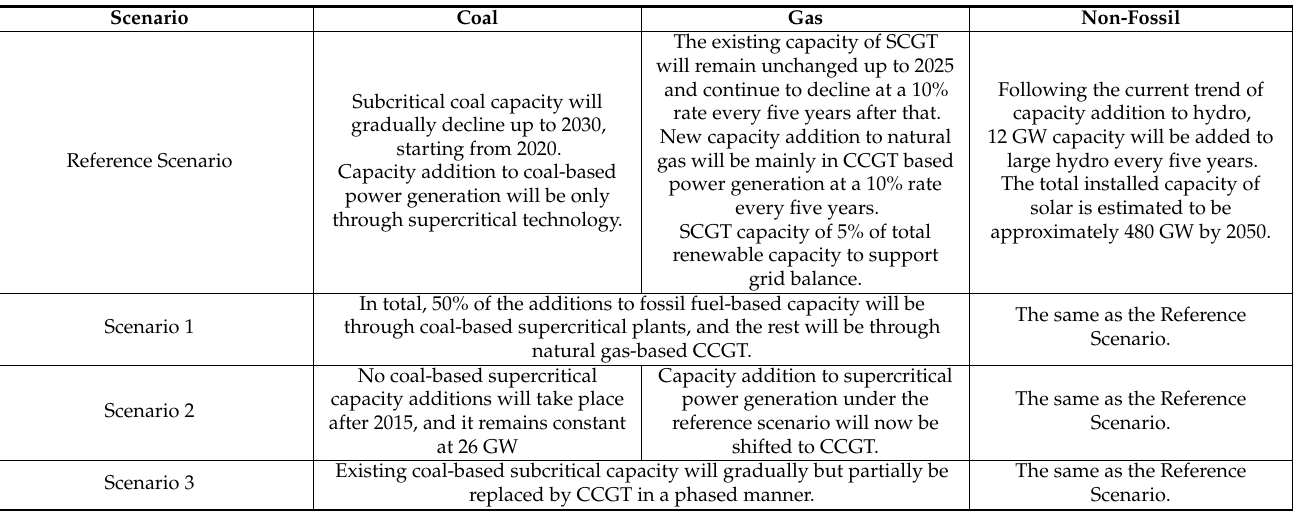
Table 3. Assumptions behind the scenarios